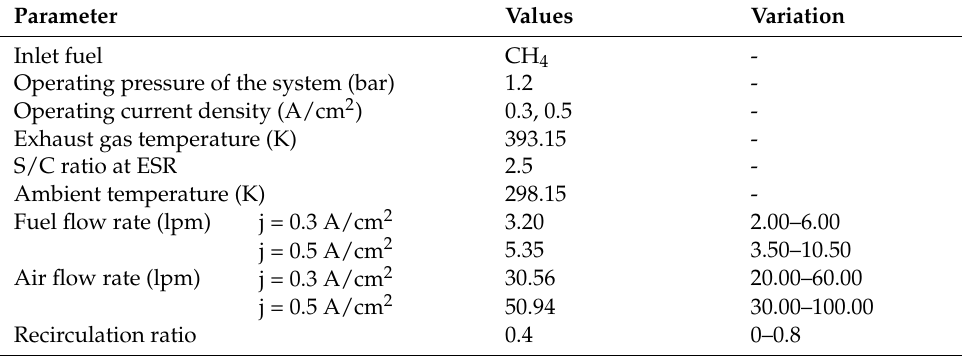
Table 4. Operating conditions for base condition and variation for sensitivity